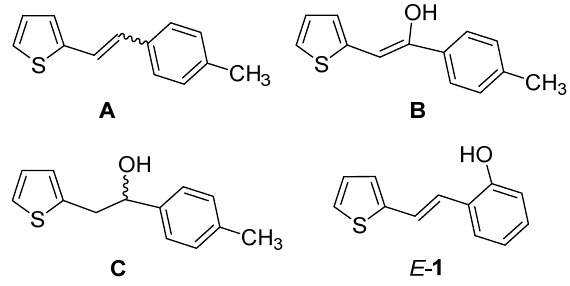
Figure 1. Structures of the substrate ( A ), its main photo-oxygenated products ( B , C ) [11], and of starting substrate E - 1 .